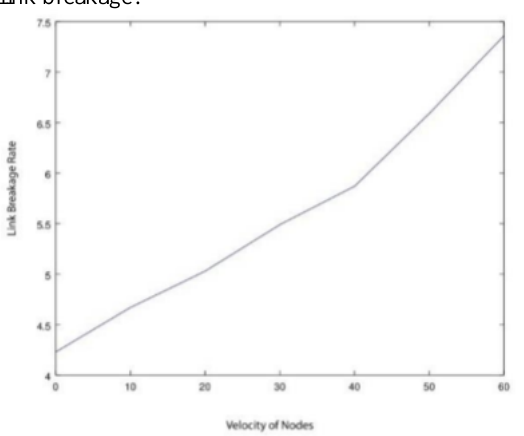
Fig. 8 reveals the HarpiaGrid’s link disconnection rate w.r.t. number of nodes. Greater the number of nodes, lesser is the possibility of link